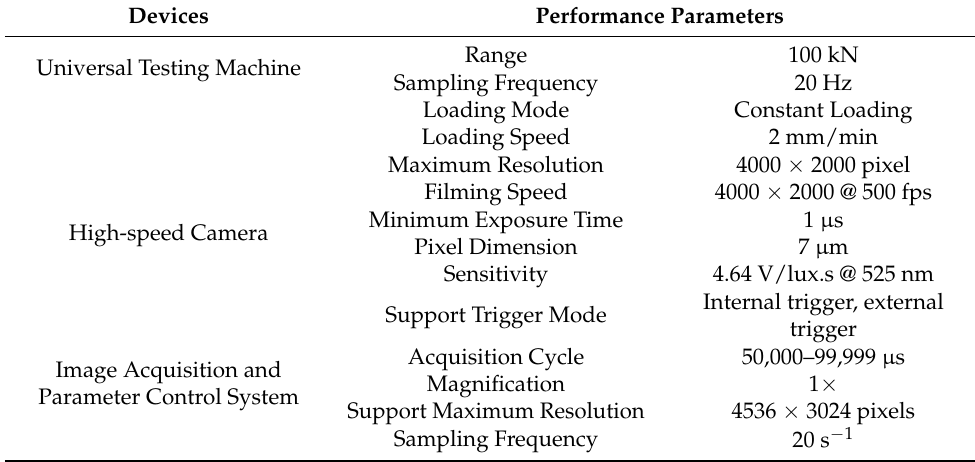
Table 1. Equipment performance parameters and experimental parameters.